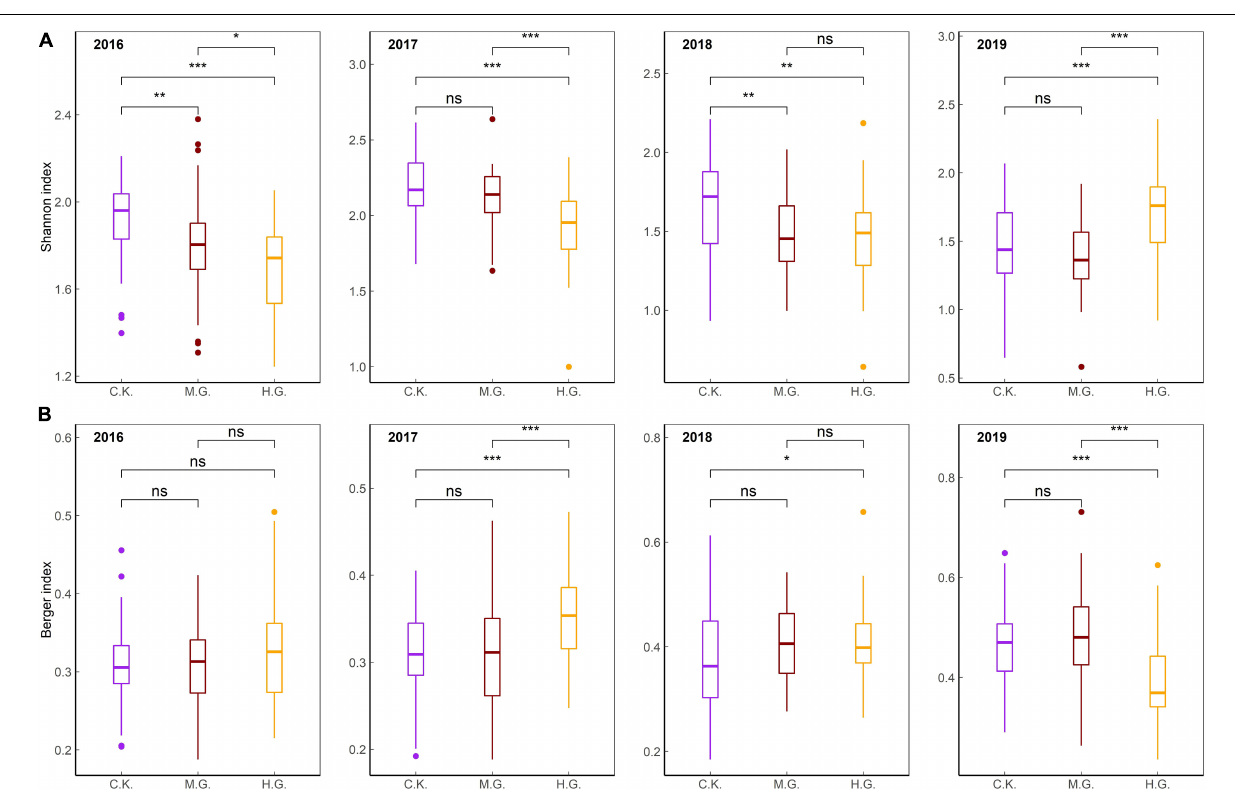
FIGURE 3 | Comparisons of the Shannon–Wiener index (A) and Berger–Parker index (B) between grazing treatments. The differences were at the ***0.001, **0.01, and *0.05 levels. The three treatments include grazing exclusion (C.K.), moderate grazing (M.G.), and heavy grazing